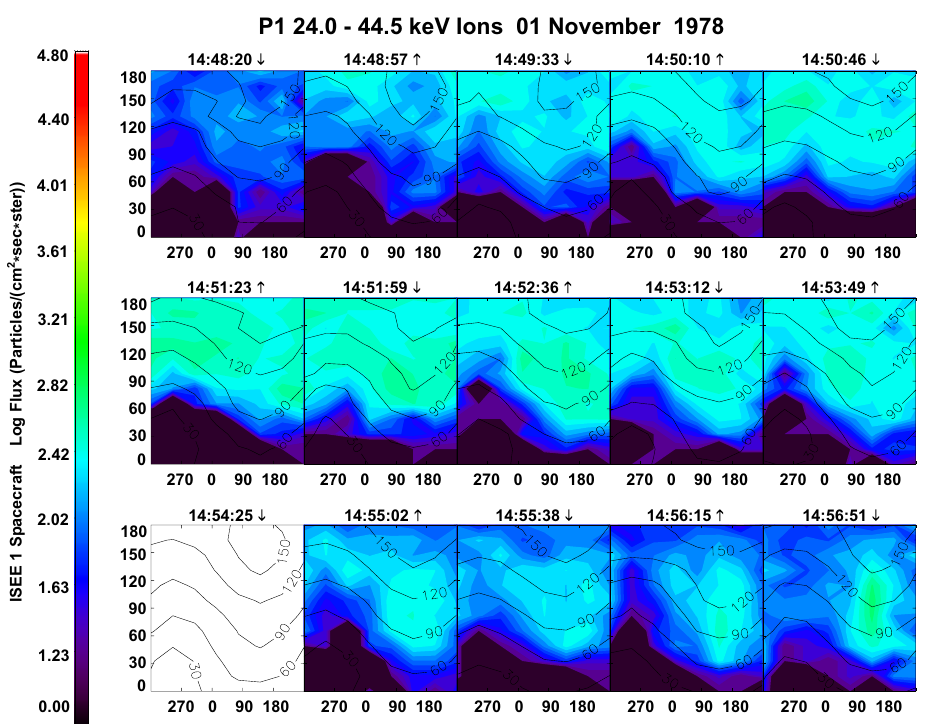
Fig. 11. A time sequence of northern hemispheric PADs for 24 to 44keV ions on 1 November 1978 (Day305) from 14:48:20UT to 14:56:51UT for the ISEE-1 Medium Energy Particles Experiment P1